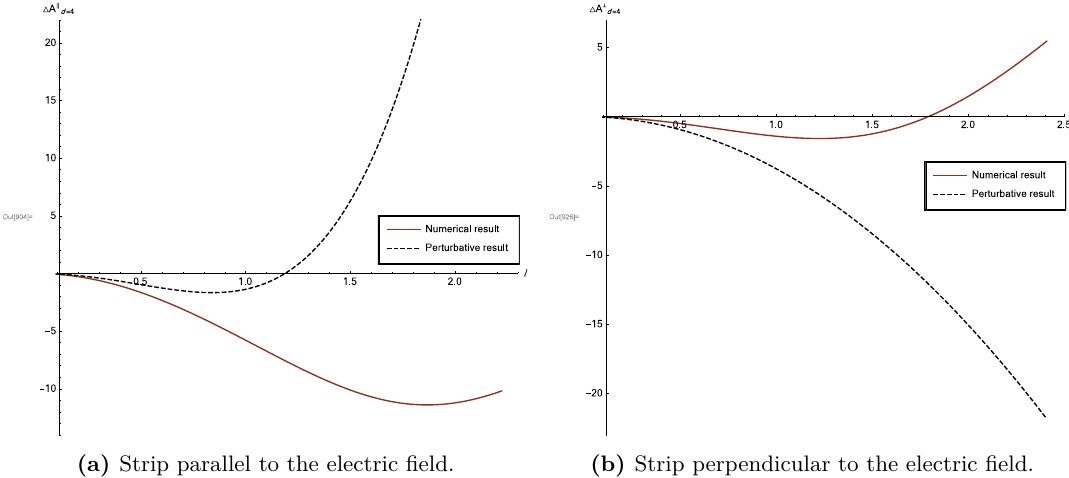
Figure 1. Comparison of perturbative and numerical results for HEE in (a) (2 + 1) and (b) (3 + 1) -dimensions, plots generated for L = 1 and z h = perturbation series.